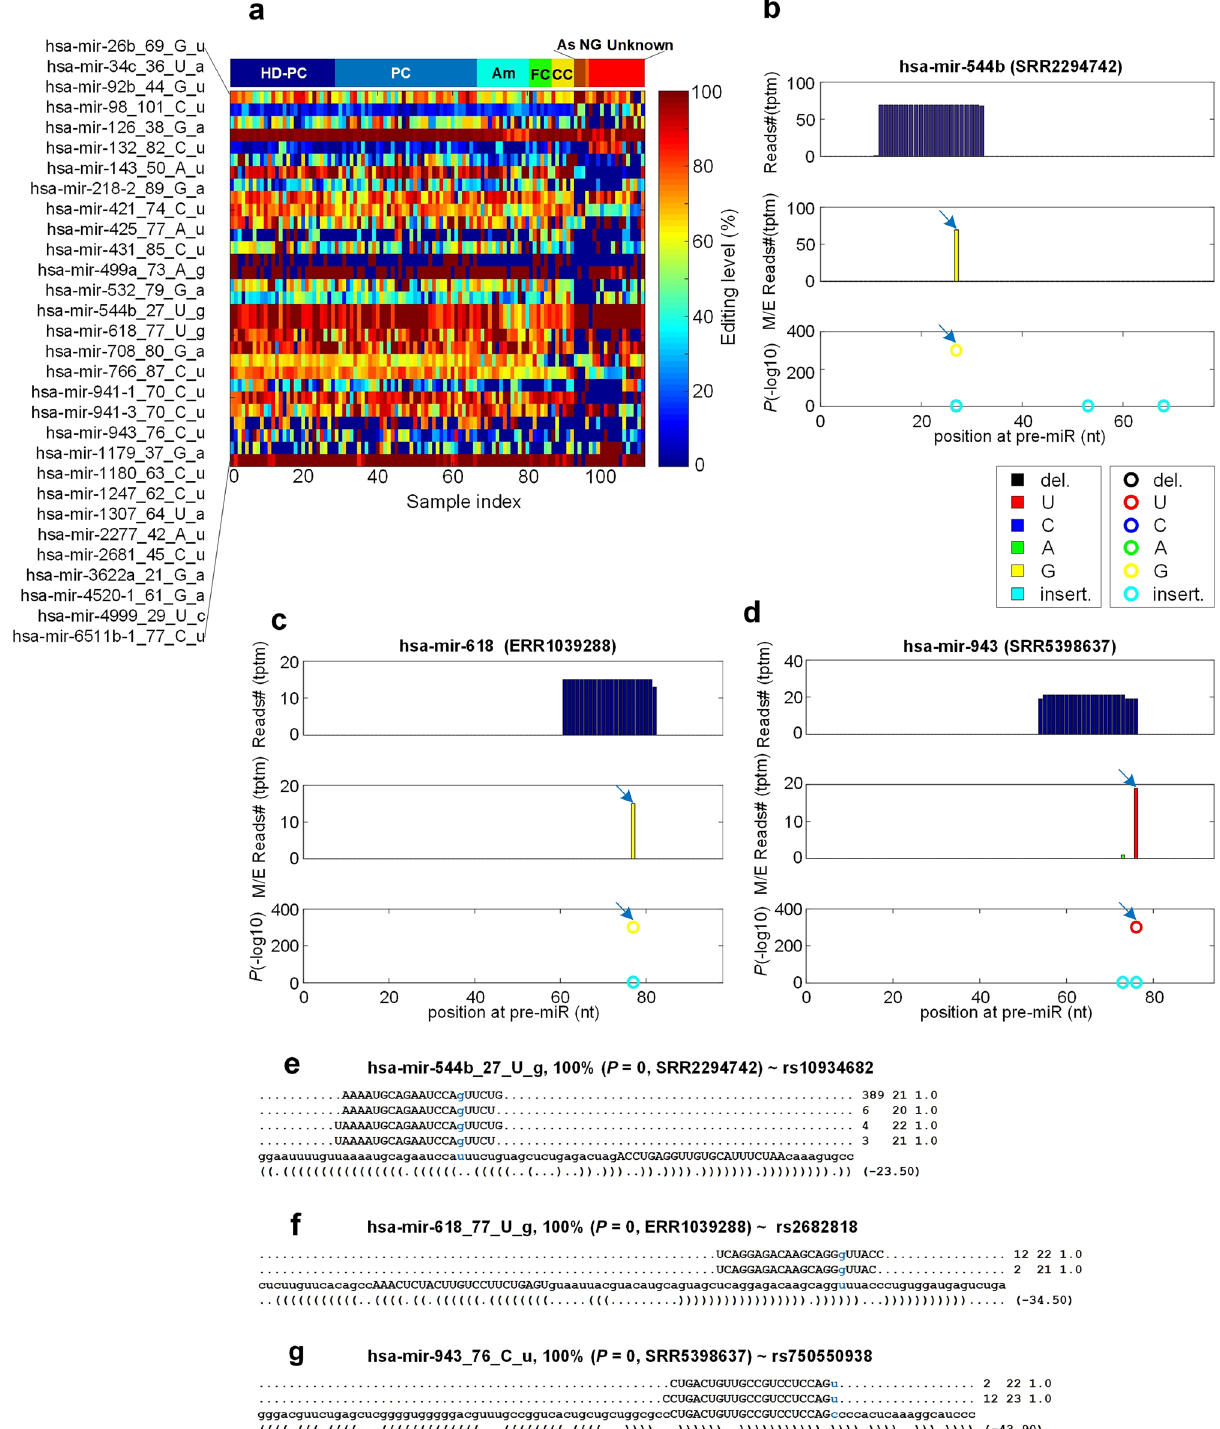
Figure 4. The details of 30 SNPs identified in miRNAs of HD patients. Legends are the same as those in Fig. 2. ( a ) The editing/mutation levels of the 30 SNP sites in the 111 selected sRNA-seq profiles. ( b ) The MiRME map of hsa-mir-544b in one of the CC samples selected (SRR2294742). ( c ) The MiRME map of hsa-mir-618 in one of the Unknown samples selected (ERR1039288). ( d ) The MiRME map of hsa-mir-943 in one of the Am samples selected (SRR5398637). ( e-g ) The details of hsa-mir-544ba_27_U_g in SSR2294742, hsa-mir-618_77_U_g in ERR1039288 and hsa-mir-943_76_C_U in SRR5398637, respectively. In Part (e)–(g), the edited nucleotides are shown in blue. And the first number on the right indicates the number of raw sequencing reads, the second number indicates the length of the reads, and the third number indicates the weight of the reads on this locus as calculated by the cross-mapping correction algorithm 84